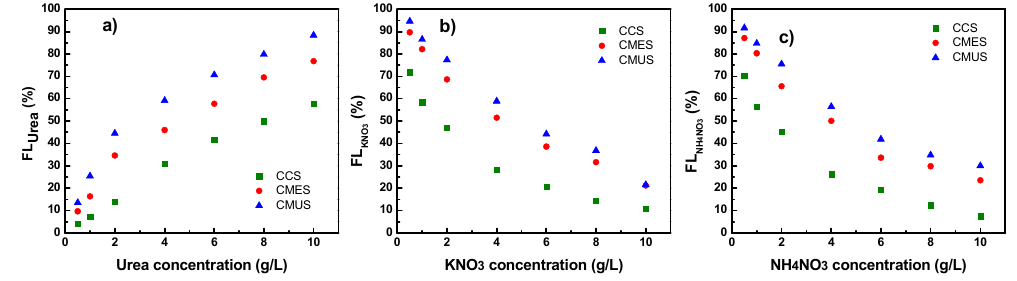
Figure 7. Fraction of loading in grafted starches: ( a ) urea, ( b ) KNO 3 , and ( c ) NH 4 NO 3 . FL urea also increased with the decrease on I (%), the F C and the increase in H ∞ . CMUS with the lowest I (%), the lowest FC and highest H ∞ presented the highest FL, while CCS showed the lowest, due to its low H ∞ and high value of I (%). The high content of -COOH groups in CCS prevented urea from entering, because of these groups promote polymer crosslinking.